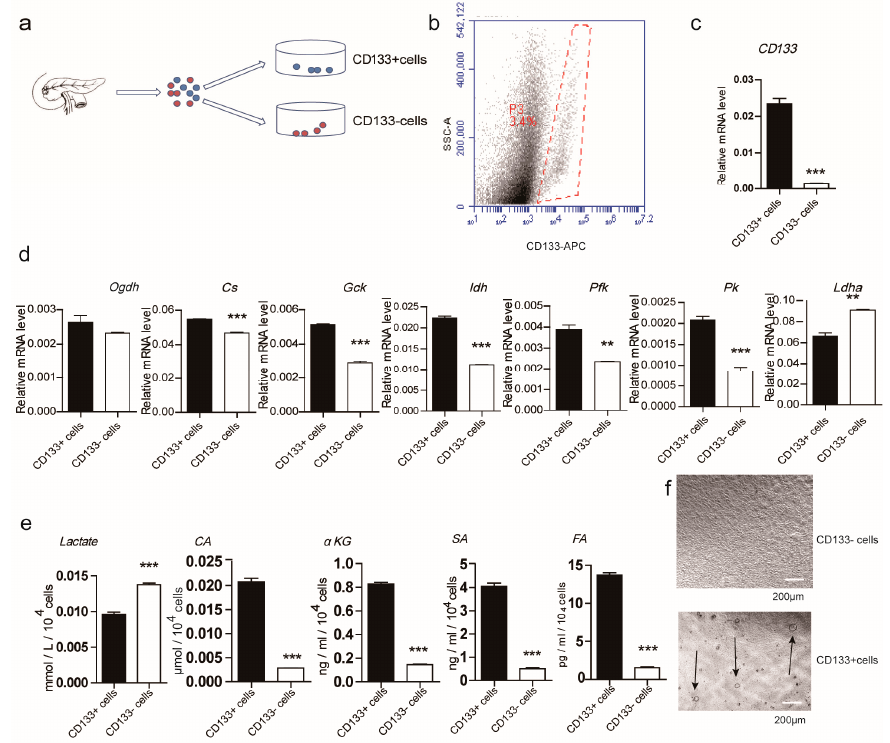
Figure 1. The metabolism levels of CD133 + and CD133 − cells in the adult murine pancreas. ( a ) CD133 + and CD133 − cells were freshly sorted by flow cytometry from pancreatic single cells; ( b ) the frequency of CD133 + cells in whole pancreatic cells was detected by flow cytometry; ( c ) the mRNA expression of CD133 and ( d ) indicated glucose metabolism related speed limit enzymes of freshly sorted CD133 + and CD133 − cells were evaluated by Real-time PCR; ( e ) glucose metabolism intermediates from CD133 + /CD133 − cells were tested by analysis kits, in accordance with the manufacturers’ instructions; ( f ) the colony forming frequencies of CD133 + cells and CD133 − cells in the 3D culture system were counted under an inverted microscope. The arrows are used to point colonies for easy viewing and identification Results are shown as means + SEM and represent three independent experiments.